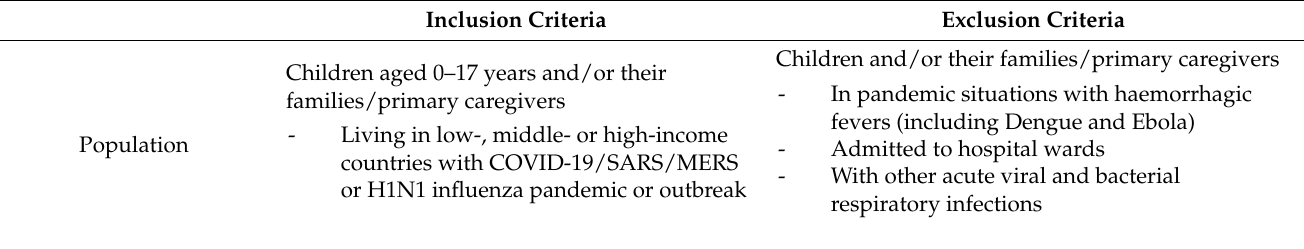
Table 1. Inclusion and exclusion